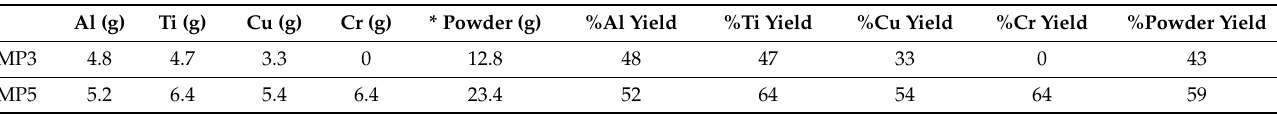
Table 6. Metal powder yield information as mass%.